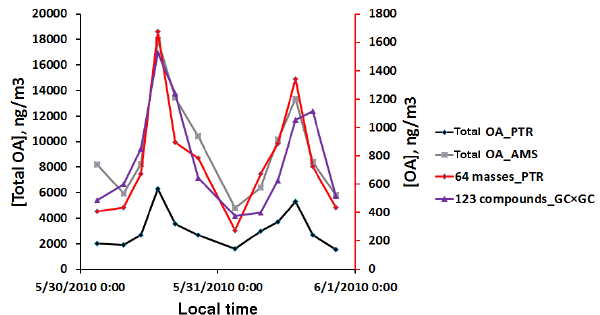
Figure 3. The 2-day cycle of total OA mass concentration (in black, total OA_PTR) and OA mass concentration of 64 masses (in red) measured with the in situ TD-PTR-MS technique, and total OA mass concentration (in grey, total OA_AMS) measured by the AMS and OA mass concentration of 123 compounds (in violet) measured with the GC × GC technique. Left y axis (in black) corresponds to total OA_PTR and total OA_AMS, and right y axis (in red) corre- sponds to 64 masses_PTR and 123 compounds_GC × GC.